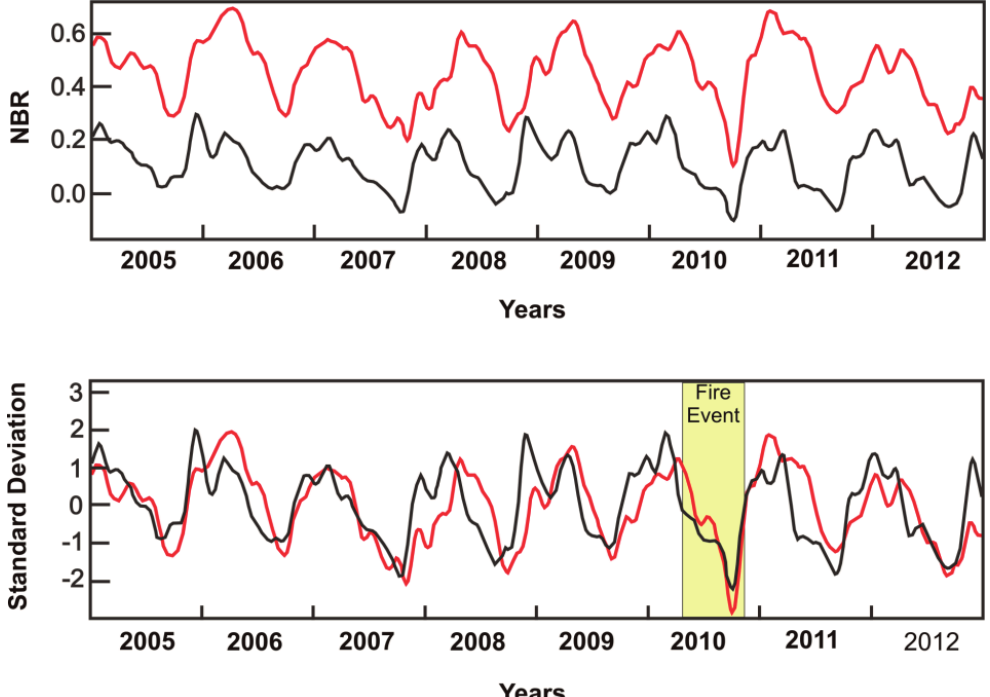
Figure 6. NBR-MODIS time series of savanna (black curve) and Closed Savanna Woodland (red curve) before and after the standardization. The standardized temporal curves homogenize and highlight the fire event, which reached different types of